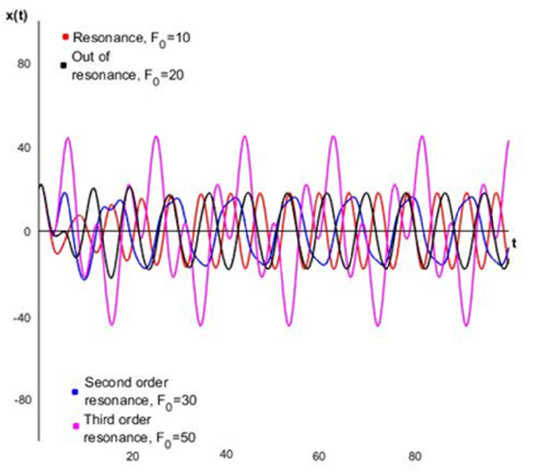
Figure 6. Position vs time plot for systems of varying degrees of resonance and realistic values of F 0 , subjected to loading expressed by Equation (6). Reproduced from [13], Published by IOP Publishing 2017.